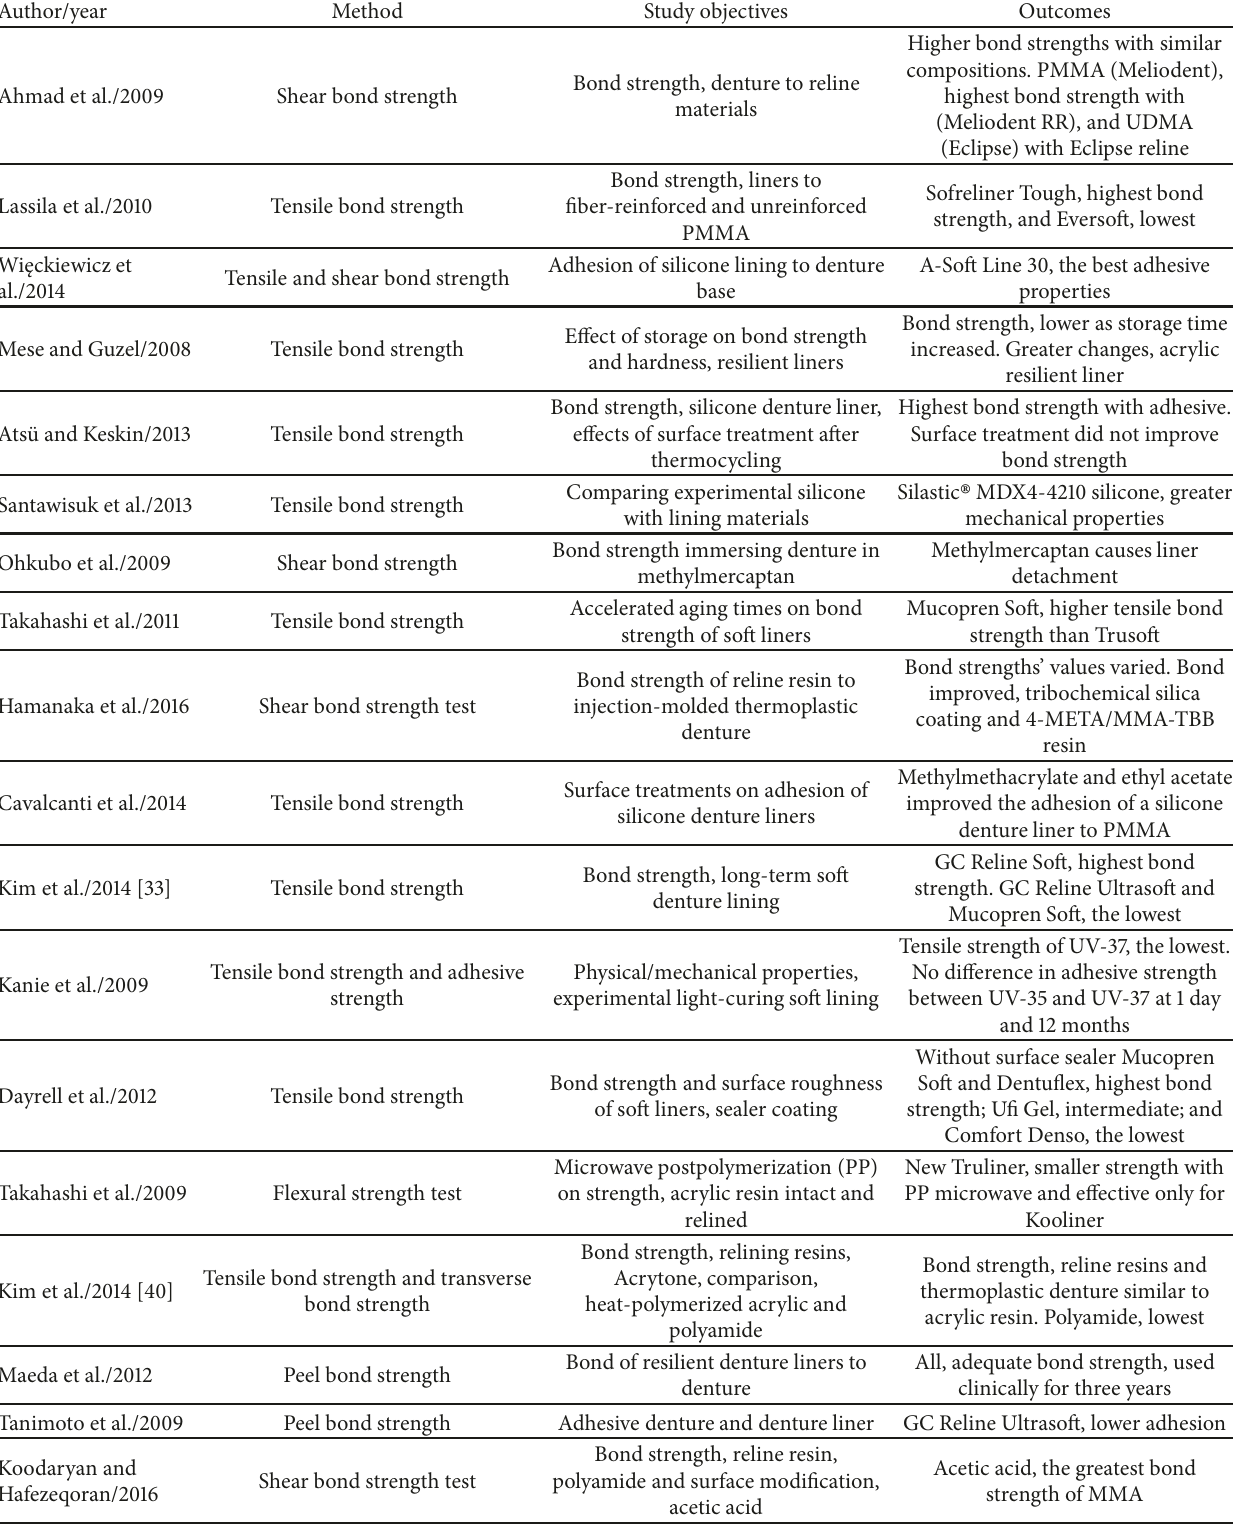
Table 1: Included studies related to the bond